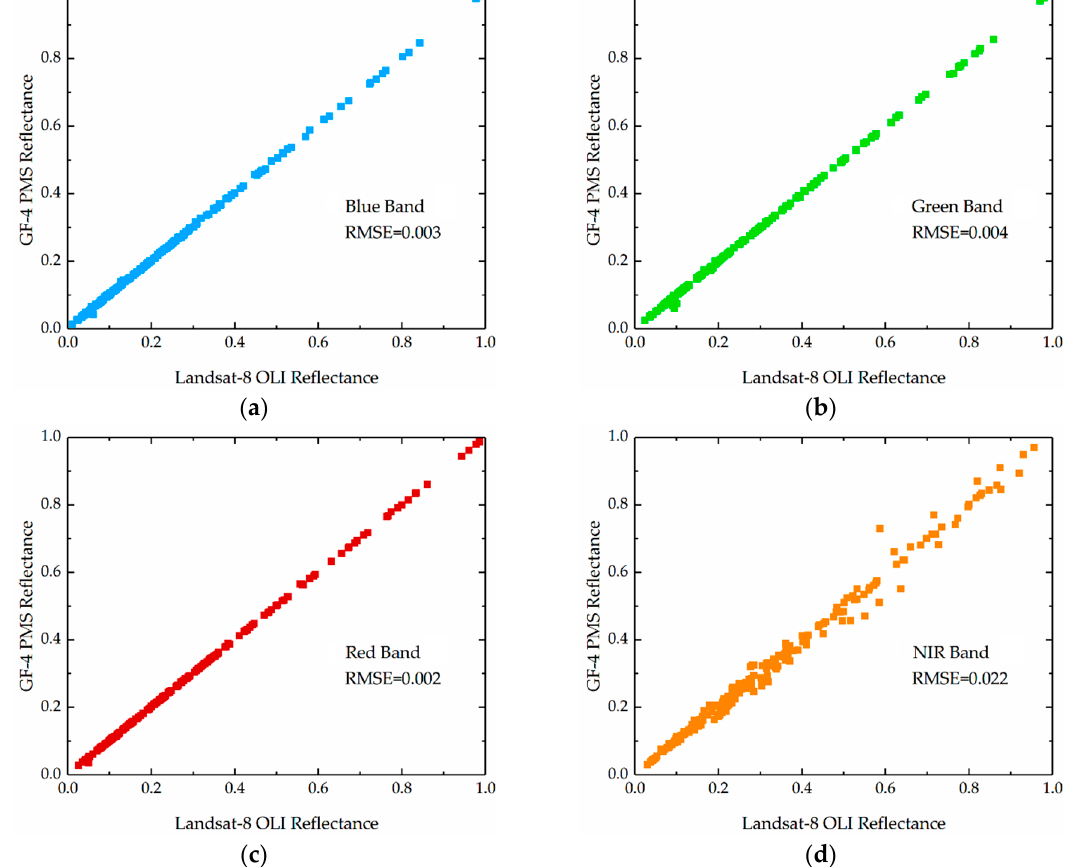
Figure 3. Scatterplot of the GF-4 PMS reflectance versus the Landsat-8 OLI reflectance: ( a ) blue band; ( b ) green band; ( c ) red band; ( d ) NIR band. RMSE: Root Mean Square Error.